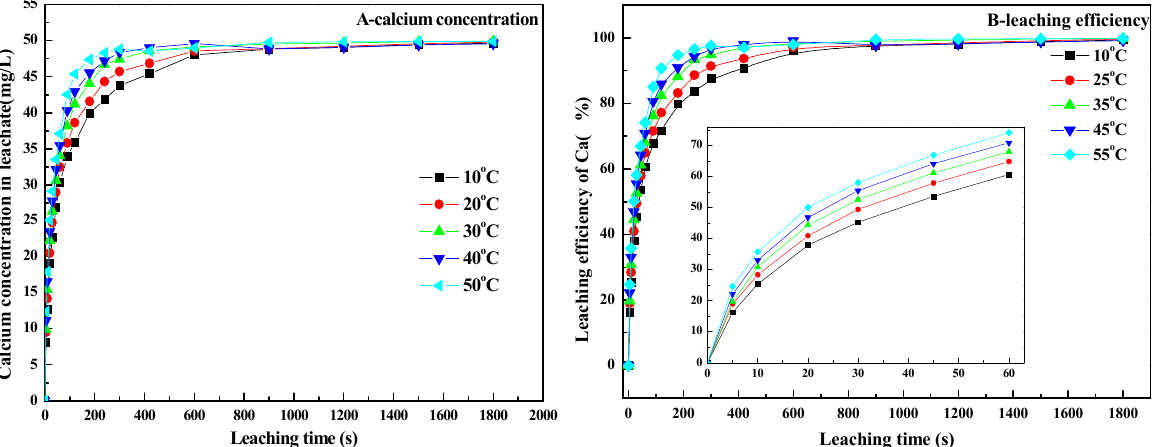
Figure 5. Effect of temperature on the leaching of calcium (C 0 = 0.20 mol/L, stirring speeds 400 r/min). Minerals 2021 , 11 , x